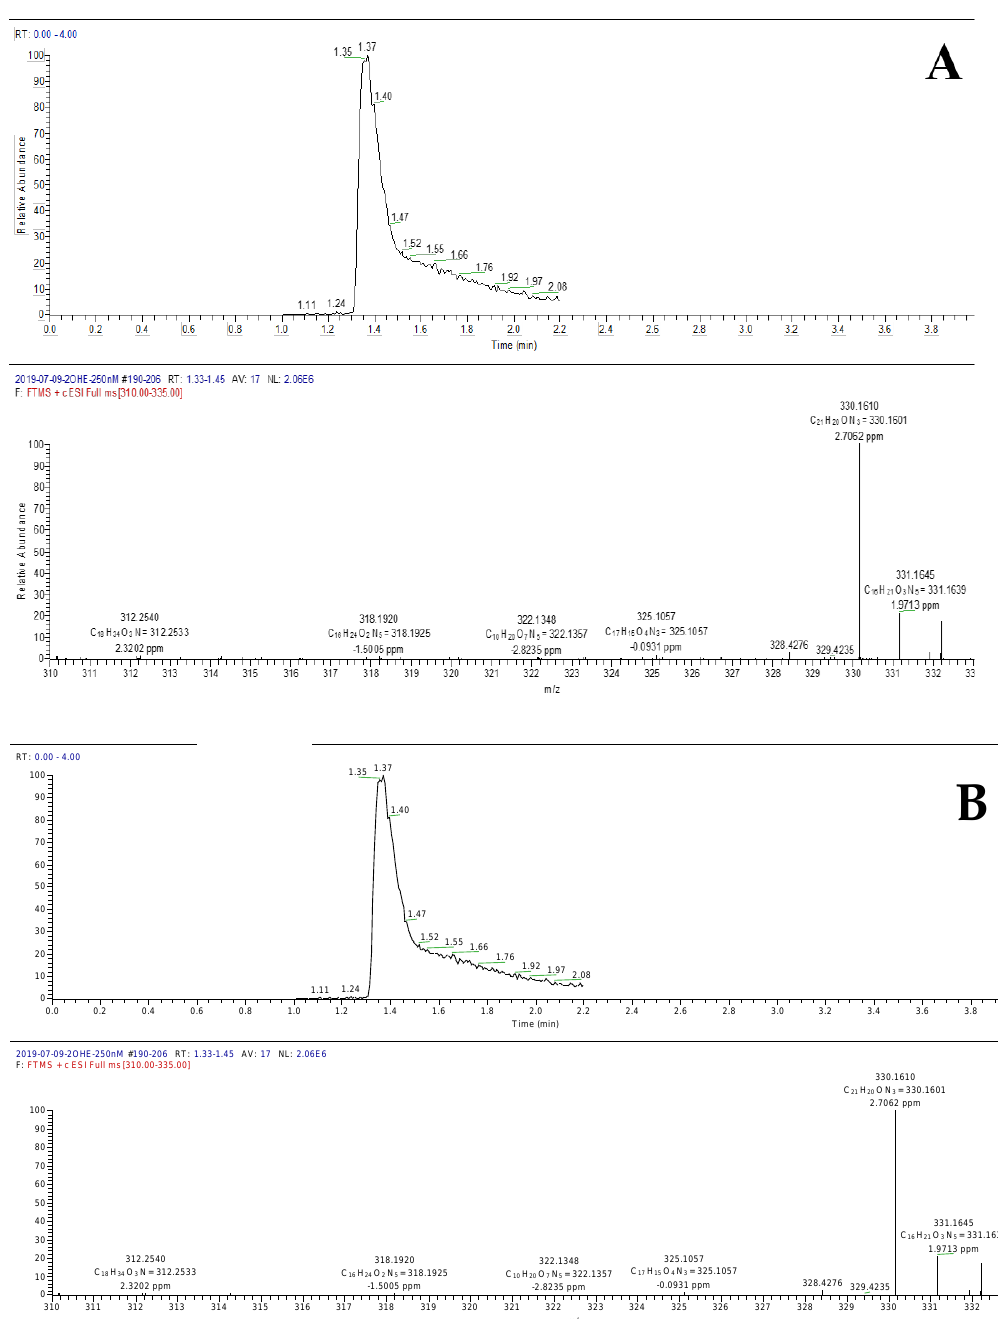
Figure 4. Extracted mass chromatogram based on m / z 330 and corresponding 2OH-E + mass spectrum ( A ). Extracted mass chromatogram base on m / z 161 and corresponding COH mass spectrum ( B